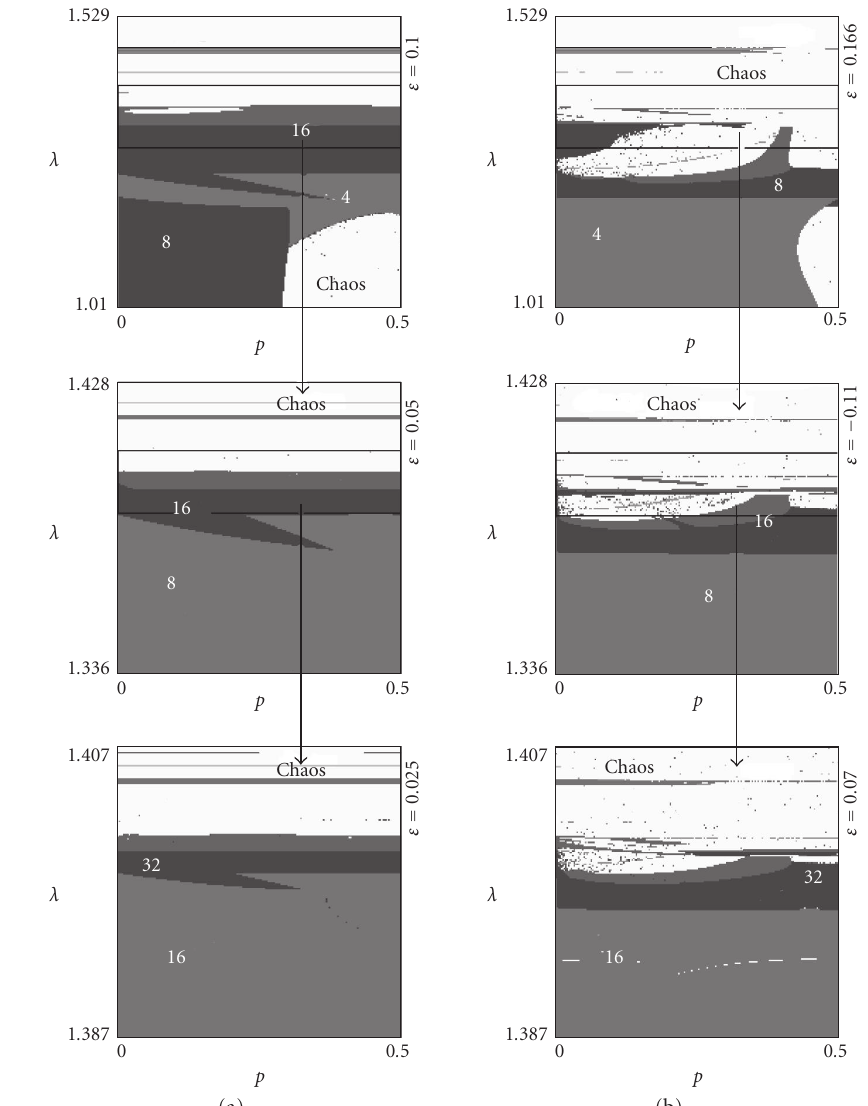
Figure 3.2. Illustrations of a scaling in the parameter space ( λ , p 1 ) for pure dissipative (left side) and pure inertial (right side) couplings for the following values of rest parameters A = 1 . 1249, B = 0 . 375, which correspond to bicritical point and ε = 0 . 25 at initial time. The factor of scaling for p 1 is equal 1.